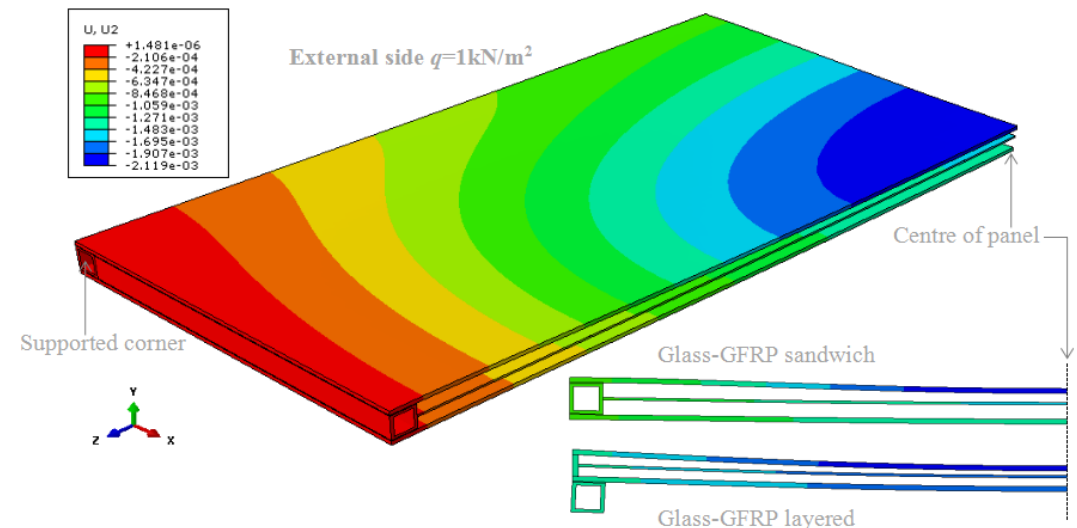
Fig. 7 Bending deformed shape of the sandwich GFRP-glass system, with cross-sectional detail (mid-span), compared to the layered GFRP solution (ABAQUS, legend in [m]).